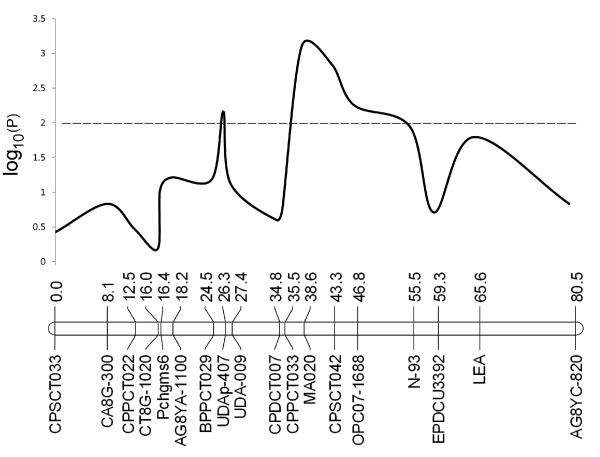
A plot of negative log10 of p-values [-log10(p)] in χ2 tests comparing frequencies of alleles of the loci in the G7 versus their map positions resulting from the One-step mapping method. A main peak was shown in the area between markers CPPCT007 and N-93. A higher -log10(p) demonstrates the higher deviation of genotype segregation of a locus from the expected Mendelian ratio. Horizontal broken line shows threshold of statistical significance [-log10(p) = 2, corresponding to p = 0.01].